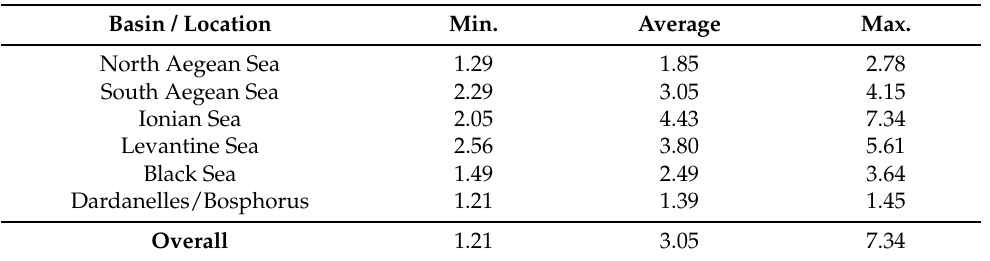
Table 1. Minimum, maximum and average grid size in km, for each individual basin (side of equivalent square area). Basin / Location Min. Average Max. North Aegean